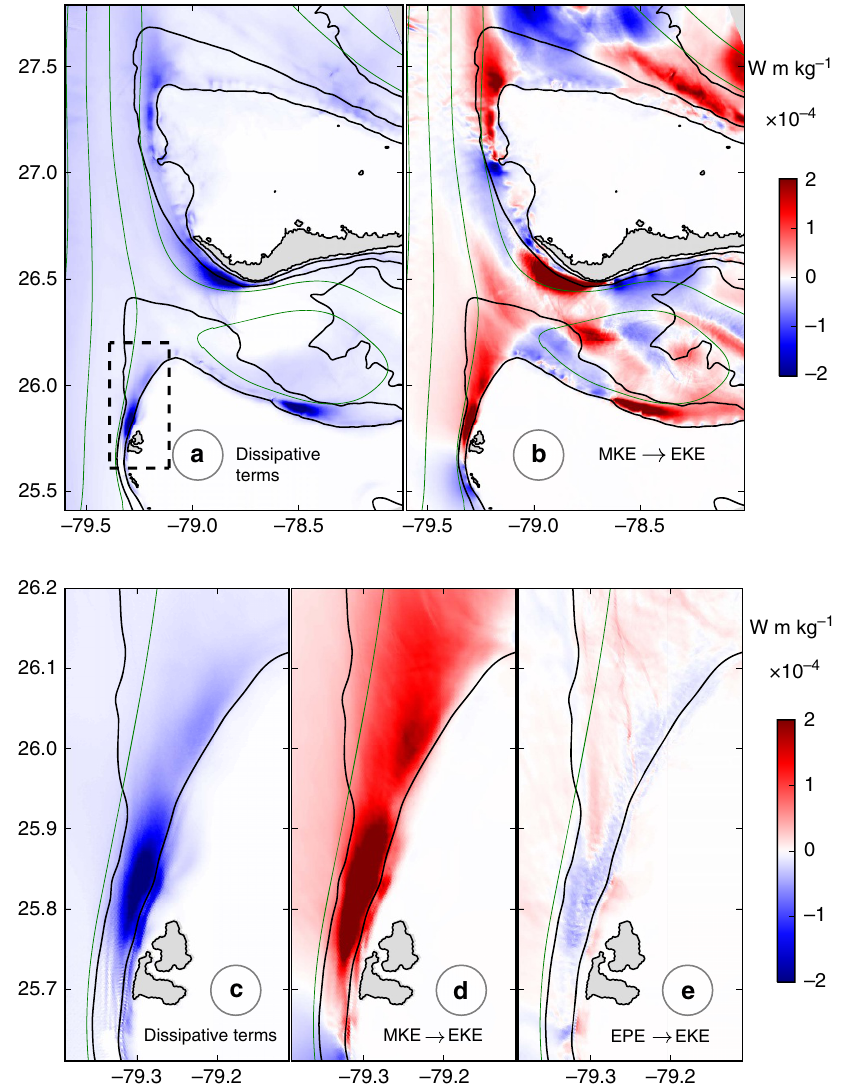
Figure 4 | Energy dissipation and mixing. Time mean depth-integrated terms of the EKE equation: ( a , c ) dissipative terms, ( b , d ) conversion from MKE to EKE, and ( e ) conversion from EPE to EKE. Bottom panels show a zoomed view in the region of strong generation along the Great Bahama Bank (black rectangle in a ). The mean transport stream function is shown in green with a 5Sv interval (1Sv ¼ 10 6 m (cid:2) 3 s (cid:2) 1 ). Units for energy rates are Wmkg (cid:2) 1 . Topography is shown in black contours at 0, 100, 500 and